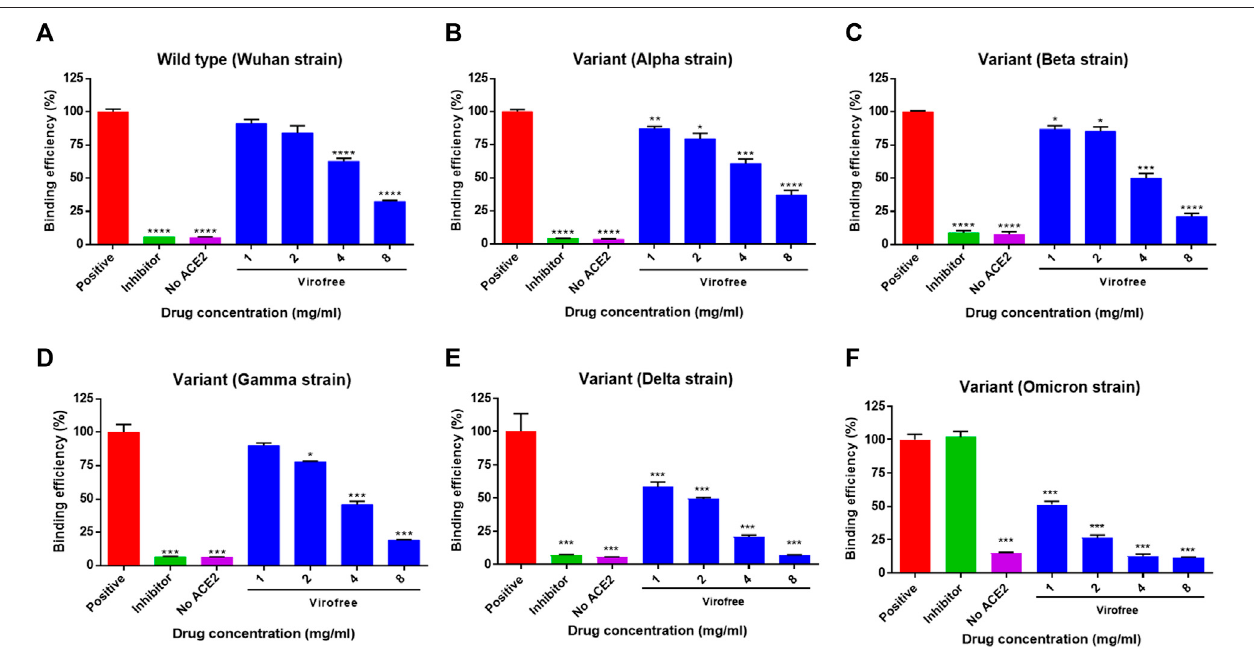
FIGURE 3 | Variant speci fi city of Virofree against the trimeric spike protein binding to ACE2. (A – E) trimeric spike proteins derived from (A) wild-type/Wuhan strain, (B) variant Alpha, (C) variant Beta, (D) variant Gamma, (E) variant Delta,and (F) variant Omicron wereused forELISA-basedspike protein andhACE2bindingassays.A positive condition represents the full binding activity of trimeric spike protein on hACE2. The inhibitor used was the wild-type spike RBD antibody (10 μ g/ml). Data represent mean ± SEM ( n = 4). *, **, or *** indicates a signi fi cant difference to the corresponding control sample with p < 0.05, 0.01, or 0.001, respectively, when compared to the binding ef fi ciency of the positive group